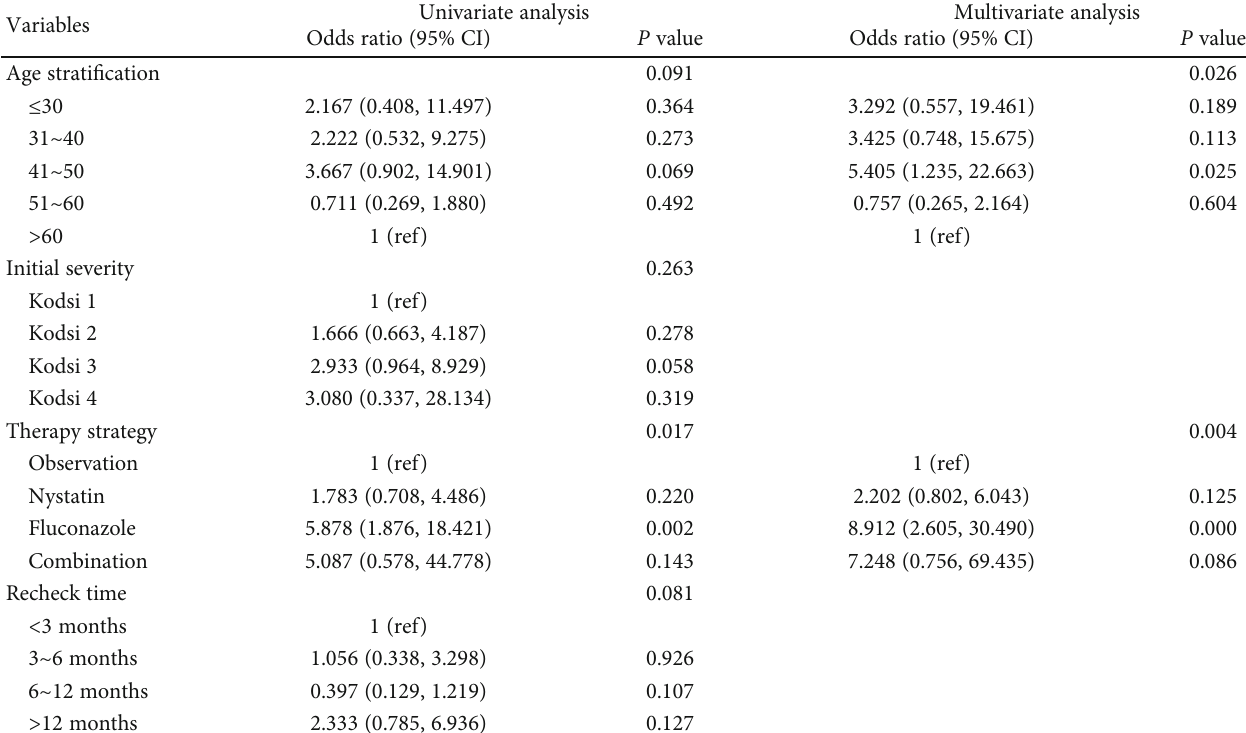
Table 6: Univariate and multivariate regression analyses of the factors related to therapeutic e ff